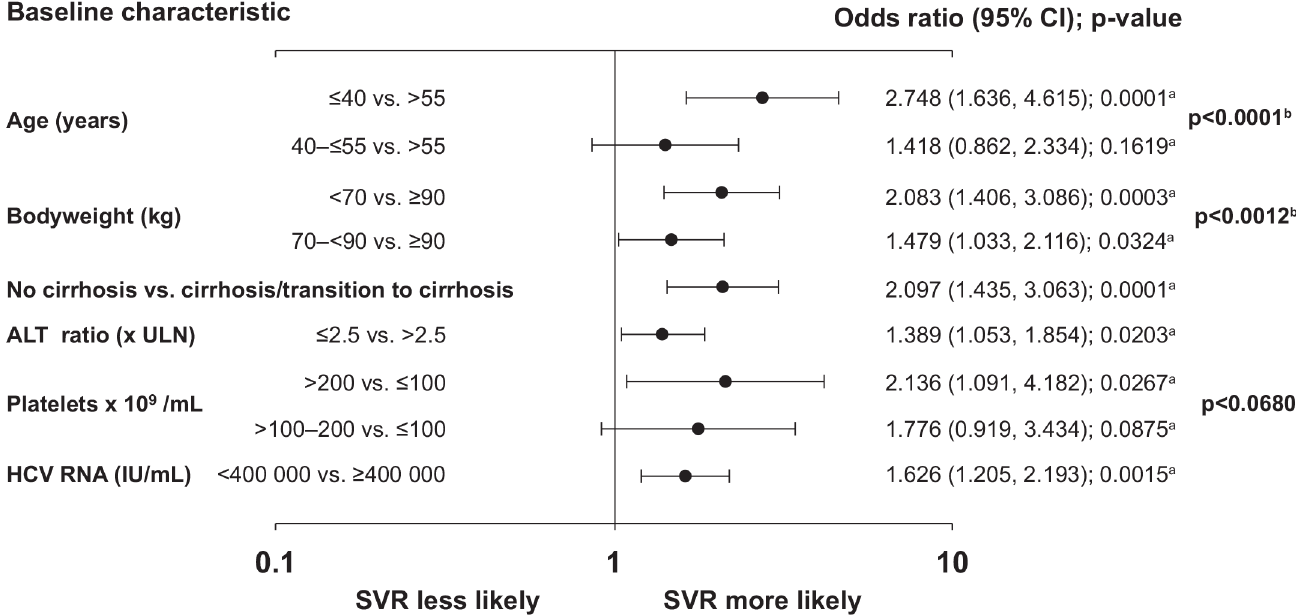
Fig 9. Multivariate logistic regression analysis. ALT = alanine aminotransferase; ALT ratio = ALT divided by ULN for the local laboratory; ULN = upper limit of normal. a Wald chi-square test for each regression coefficient; b Wald chi-square test for each